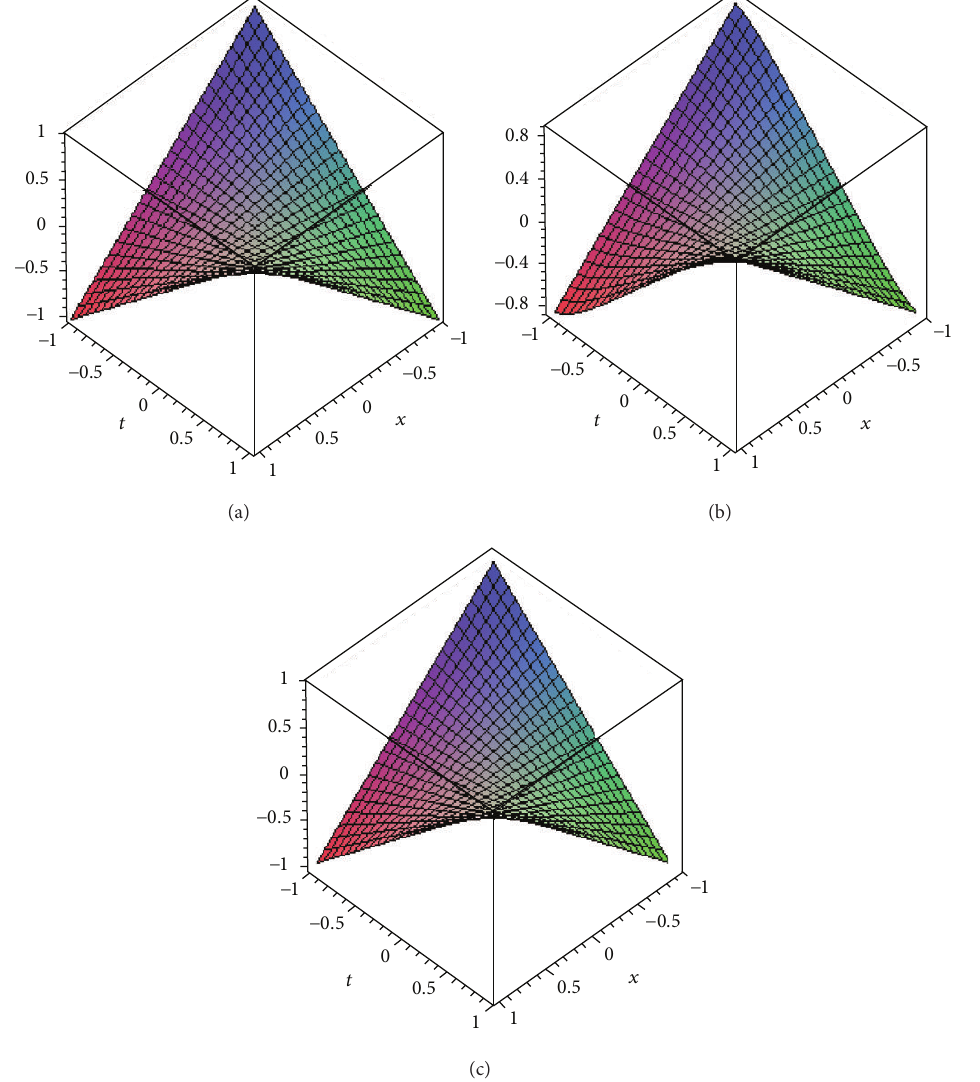
Figure 1: (a) Exact solution of Example 1 for 𝛼 = 1 (b) ADM solution of Example 1 for 𝛼 = 1 (c) Multivariate Pad´e approximation of ADM solution for 𝛼 = 1 in Example